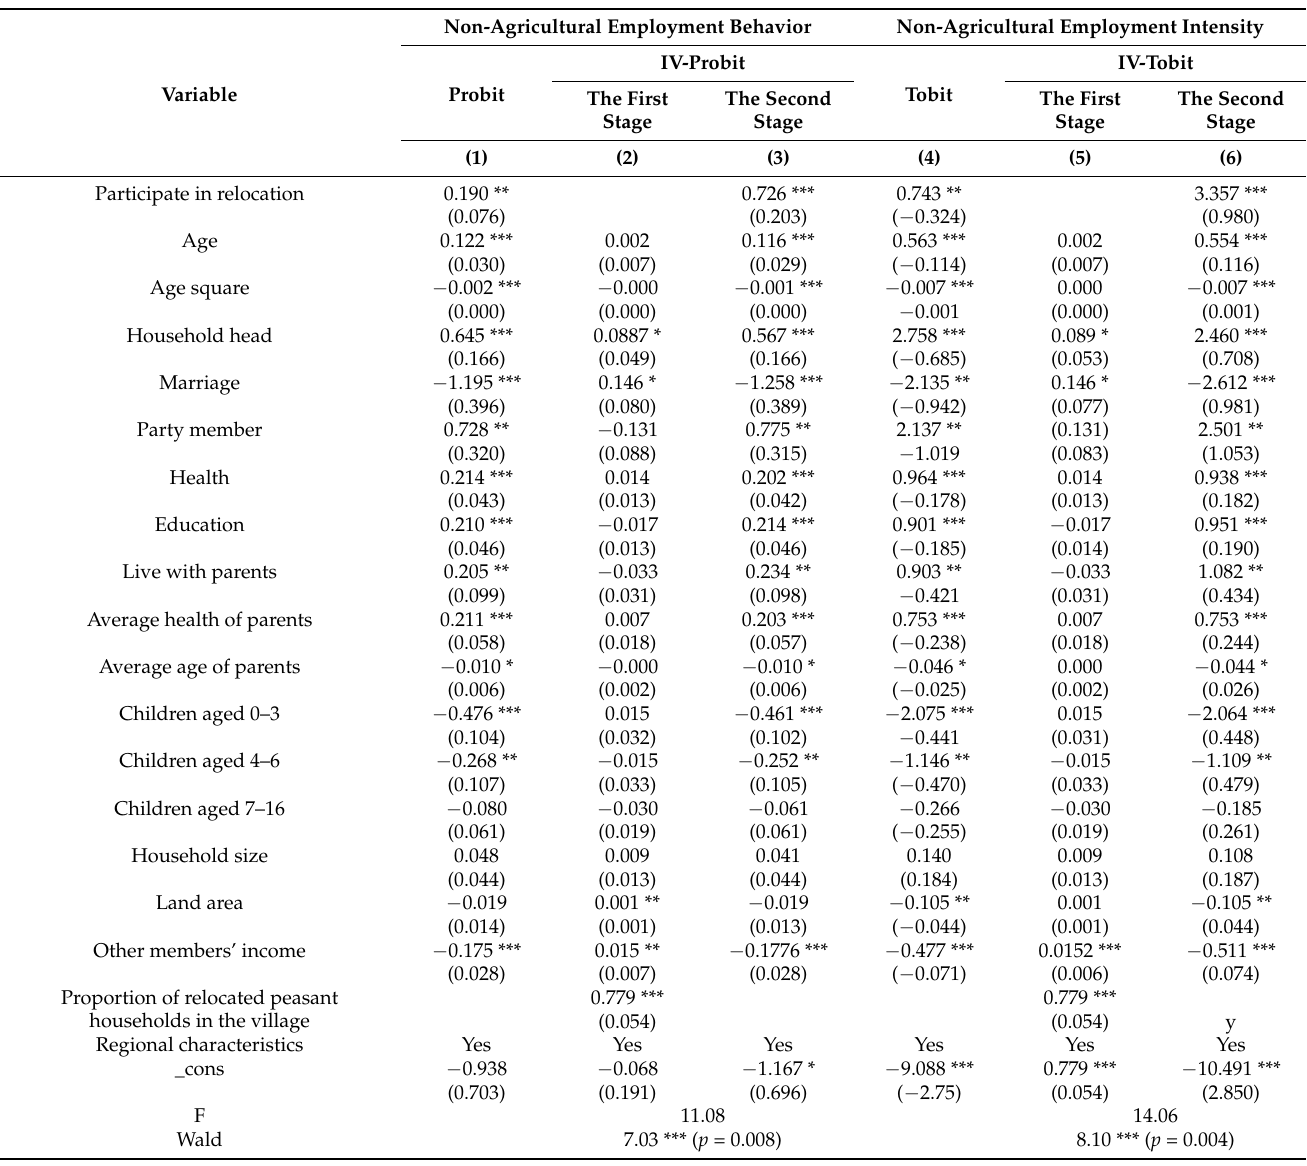
Table 2. Results of the impact of participation in relocation on women’s non-agricultural